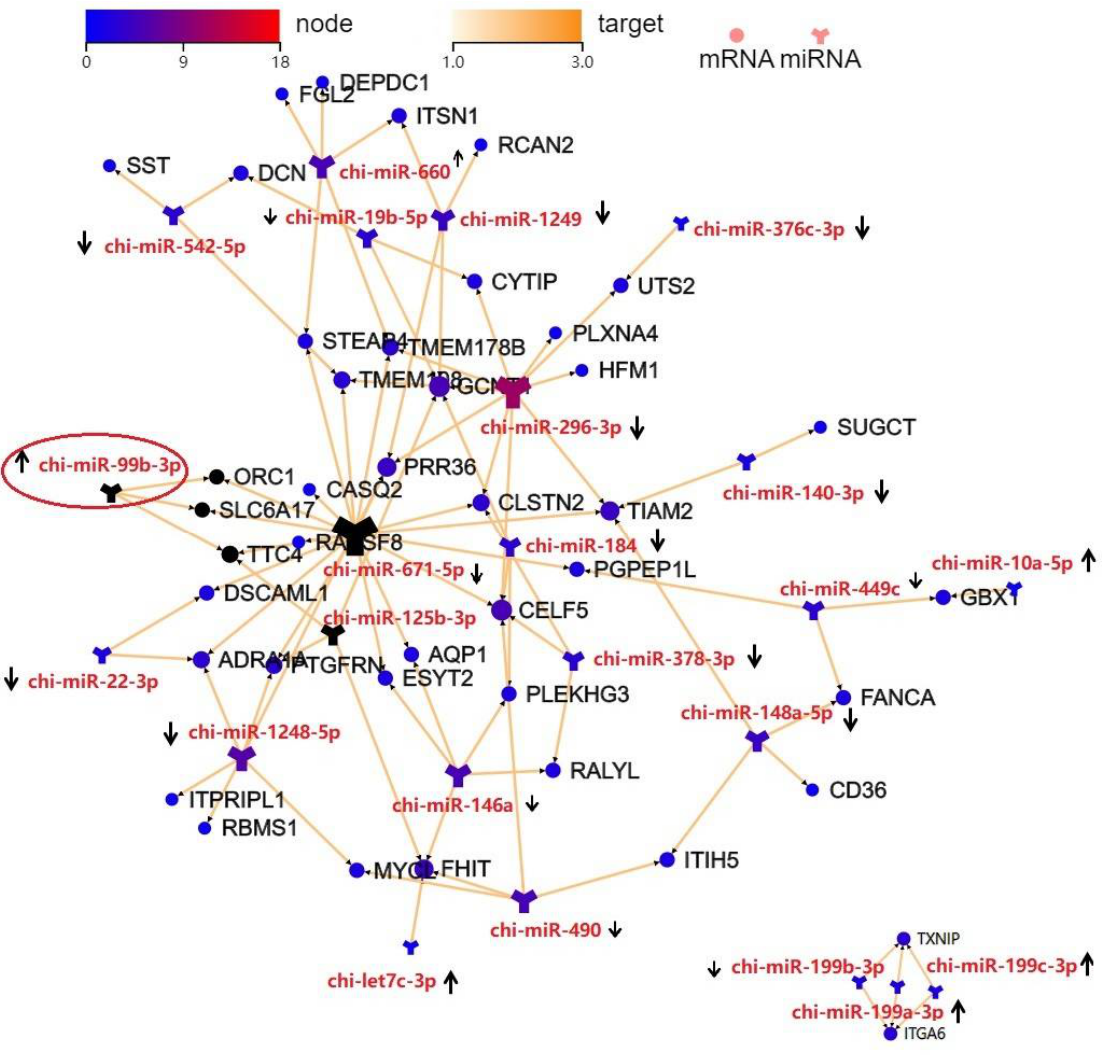
Figure 6. miRNA–mRNA interaction network in SMSCs after miR-99b-3p overexpression. DE miRNAs and mRNAs were considered.